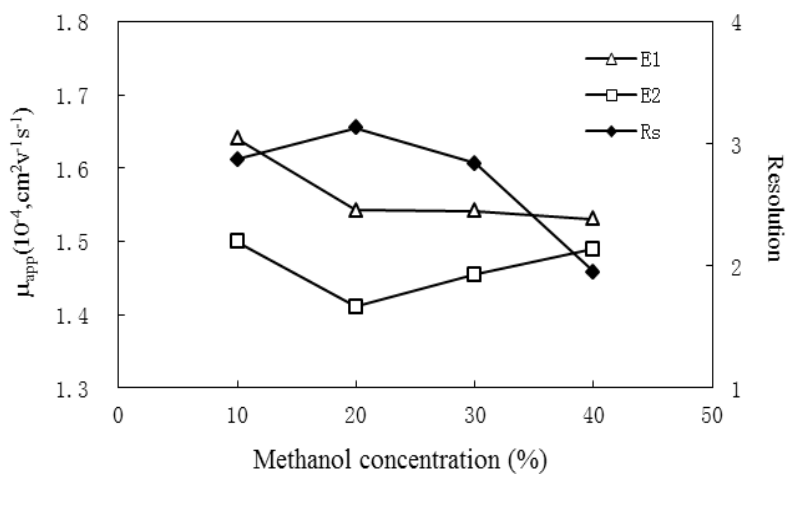
Figure 2. The effect of methanol concentration on resolution. Separation condition: 20 mmol/L SBE - β -CD in 20 mmol/L phosphate buffer (pH 7.0); temperature, 25 °C; 7 applied voltage, 20 kV; detection wavelength, 225 nm; injection, 50 mbar for 5 s; capillary, 50 cm × 50 μ m i.d. with effective length of 41.5